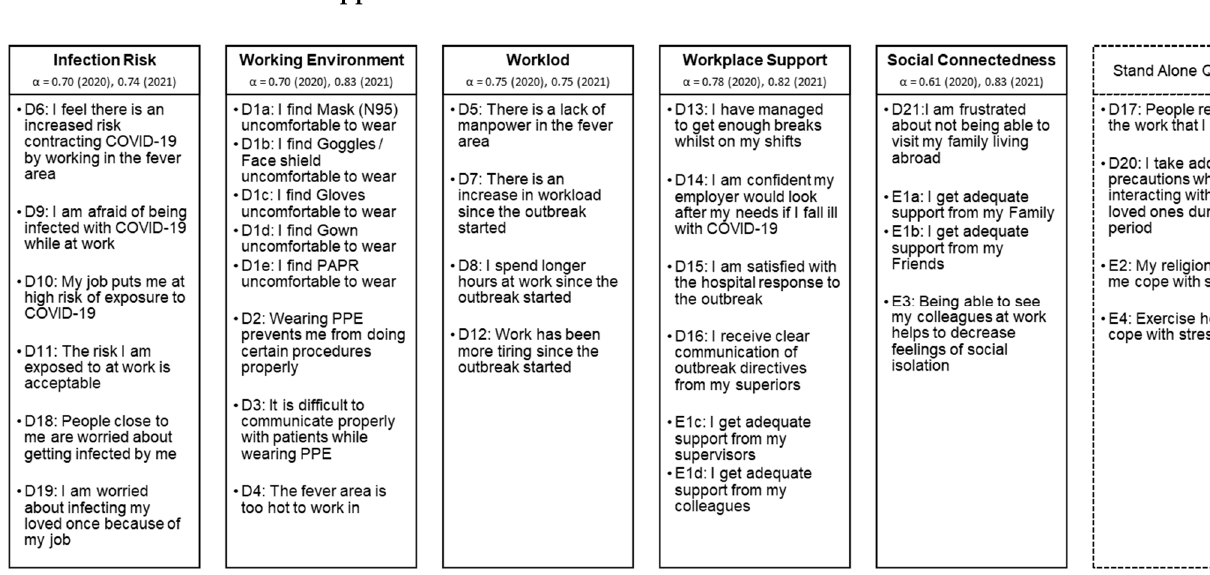
Figure A2. Questions on participants’ concerns and perceptions were categorised based on content relevance shown below for data analysis with listed factor analysis (Cronbach’s alpha, α ).